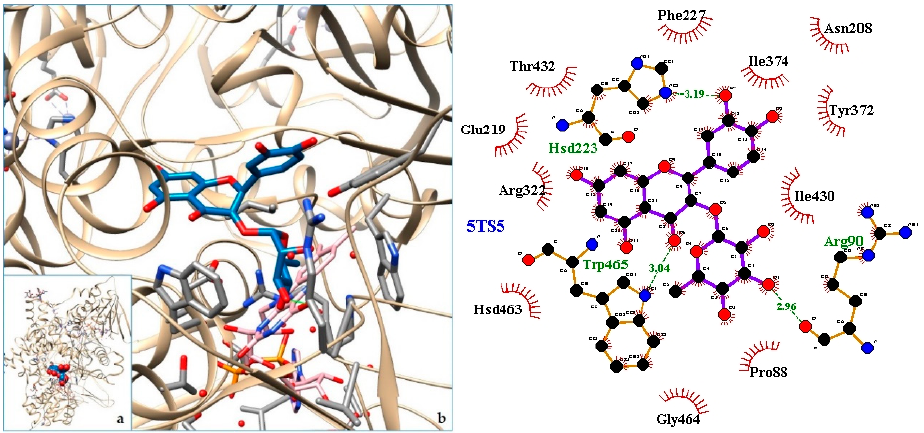
Figure 4. 5TS5-quercetrin complex. in the most favourable arrangement ( a ) and augmented ( b ) showing the disposition between the chain of toxins. Right: 2D interaction diagram.